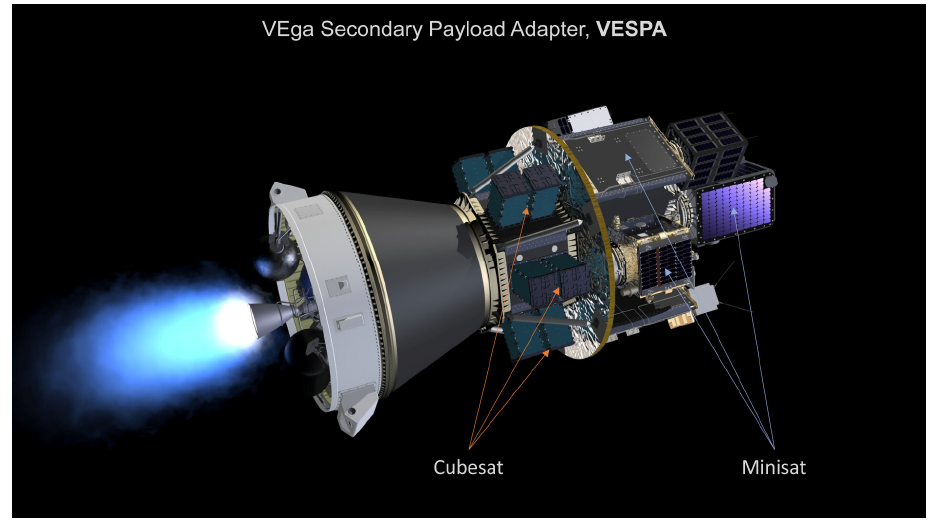
Figure 1. SSMS representation with different types of small satellites (copyright of ESA-J. Huart).